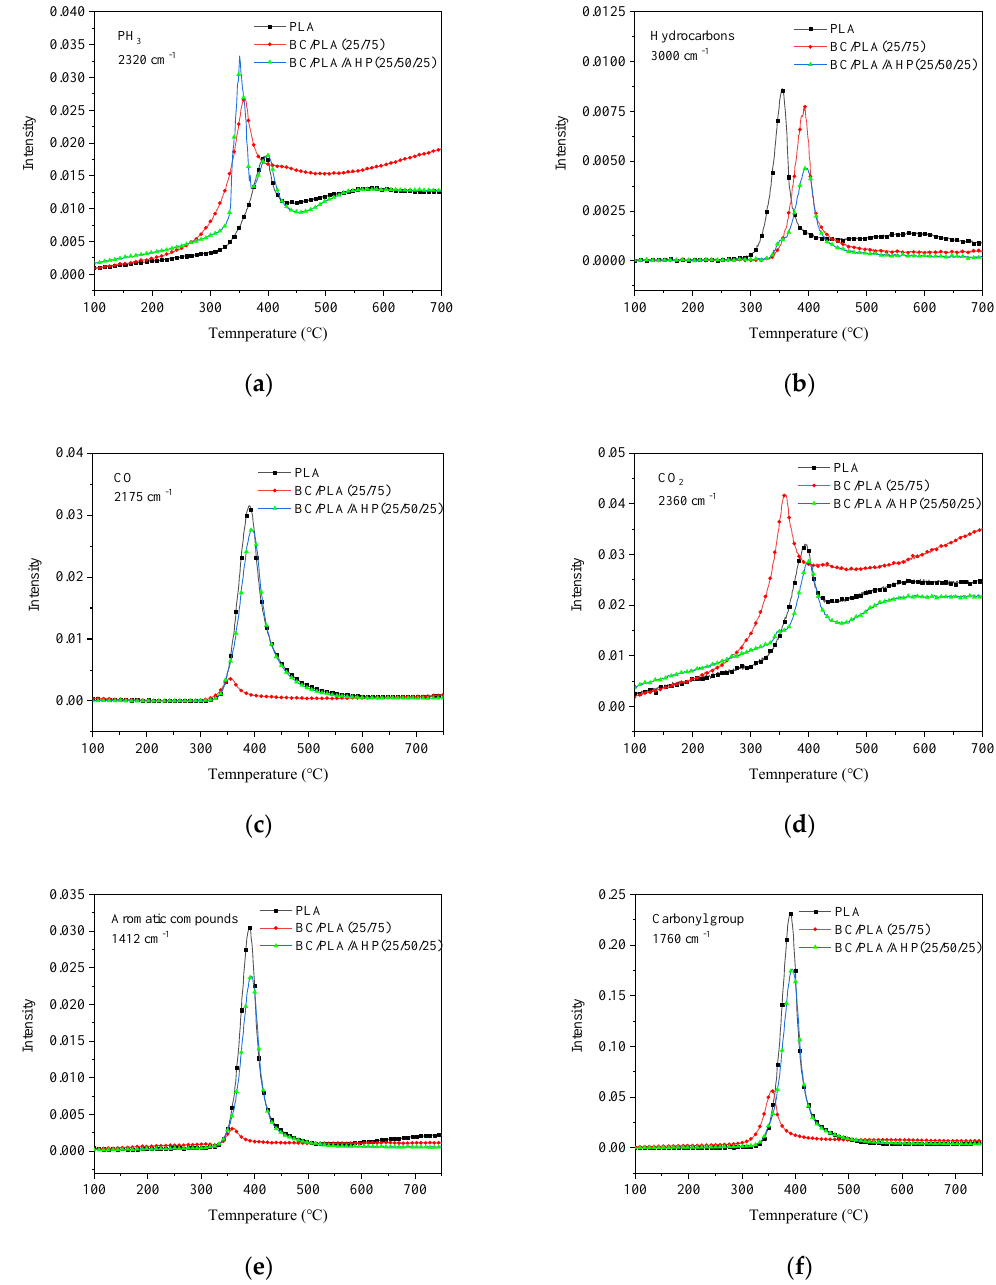
Figure 7. Absorbance spectra for pyrolysis products ( a ) PH 3 , ( b ) hydrocarbons, ( c ) CO, ( d ) CO 2 , ( e ) aromatic compounds, and ( f ) carbonyl groups for PLA, BC/PLA, and BC/AHP at various temperatures.